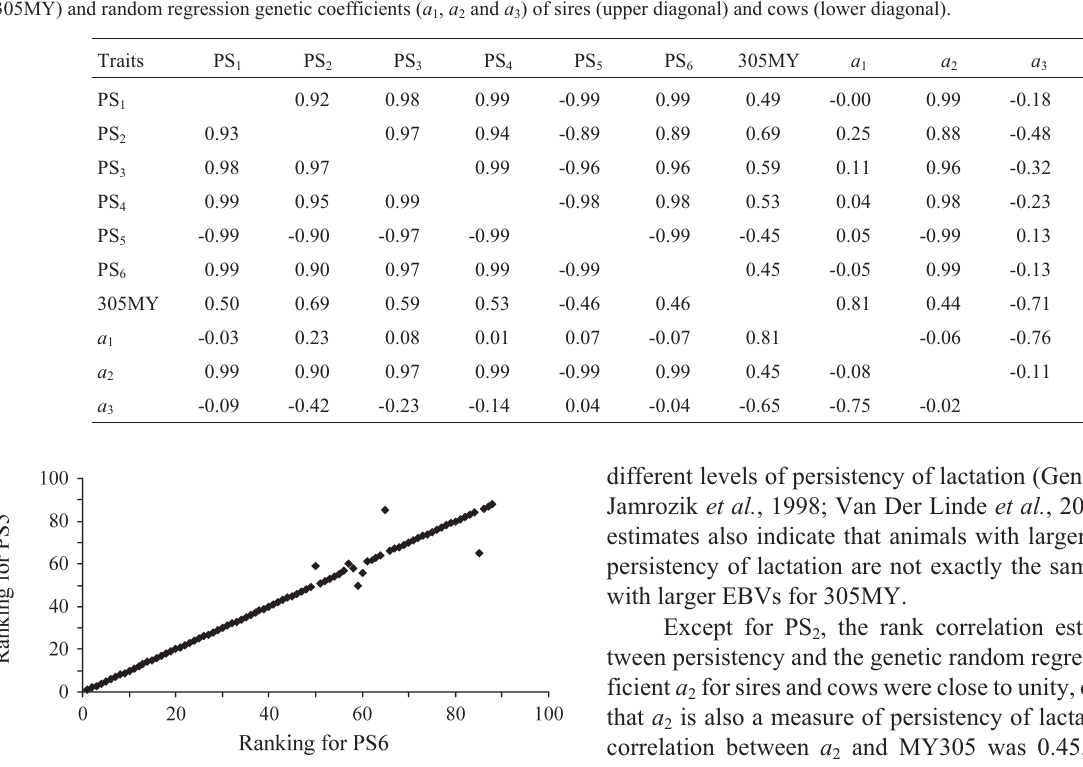
Figure 1 - Dispersal in ranking of sires with more than 25 daughters for the PS5 and PS6 measurements of persistency of